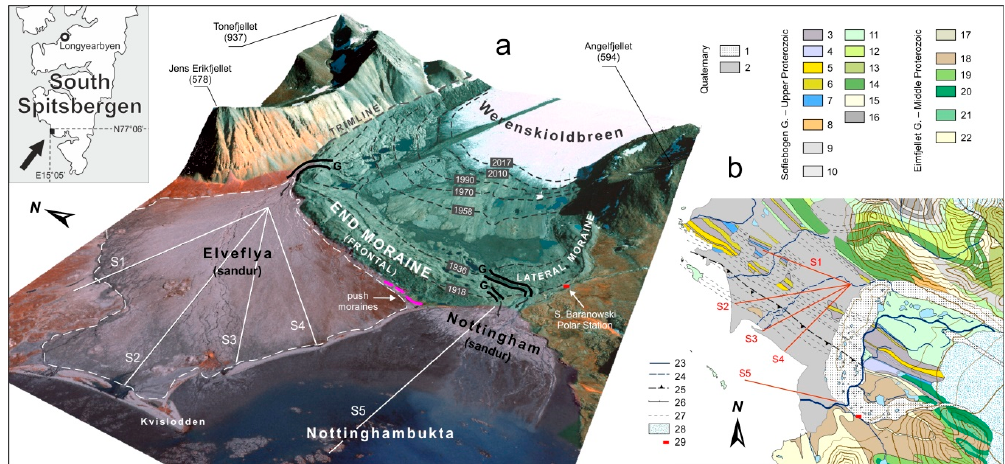
Figure 2. Study area: ( a ) oblique view; glacier terminus after Ci ęż kowski et al. [67], modified; ( b ) geological sketch based on Czerny et al. [71], simplified: Quaternary; 1—moraines, 2—fluvial deposits, ground moraine deposits and marine shore deposits; Upper Proterozoic, Elveflya Formation; 3—marble-quarzite and granite-quarzite metaconglomerates, 4—gray calcite marbles, 5—yellow quarzites and quartzitic schists, 6—mica-carbonate-quartz schists (including dropstones), 7—black chloritoid-bearing quartz-paragonite-muscovite schists; Slyngfjellet Formation; 8—Yellowish muscovite-carbonate-quartz schists; Gashamna Formation; 9—black phyllites; Hoferpynten Formation; 10—gray dolostones and black calcite marbles; Jens Erikfjellet Formation; 11—laminated greenstones with epidotite lenses, 12—black greenstones, 13—greenstones with metachert intercalations, 14—greenstones, 15—pink calcite marbles, 16—greenschists and carbonate-chlorite-quartz schists; Middle Proterozoic, Eimfjellet Group, 17—chlorite and muscovite-chlorite diaphthoritic schists; Bratteggdalen Formation; 18—mica schists with intercalations of amfibolites, metarhyolites, quartzites and laminated quartz-feldspar felses, 19—amphibolites interbedded with chlorite and biotite schists, 20—black coarse-grained amphibolites; Skalfjellet Formation; 21—amphibolites with anorthositic metagabbro enclaves; Gulliksenfjellet Formation; 22—white and green quartzites; 23—rivers, 24—abandoned river channels, 25—thrust faults, 26—faults, 27—geological boundaries, 28—glacier ice, 29—Stanis ł aw Baranowski Polar Station; G—gorges, S1–S5—electromagnetic induction (EMI) sections.